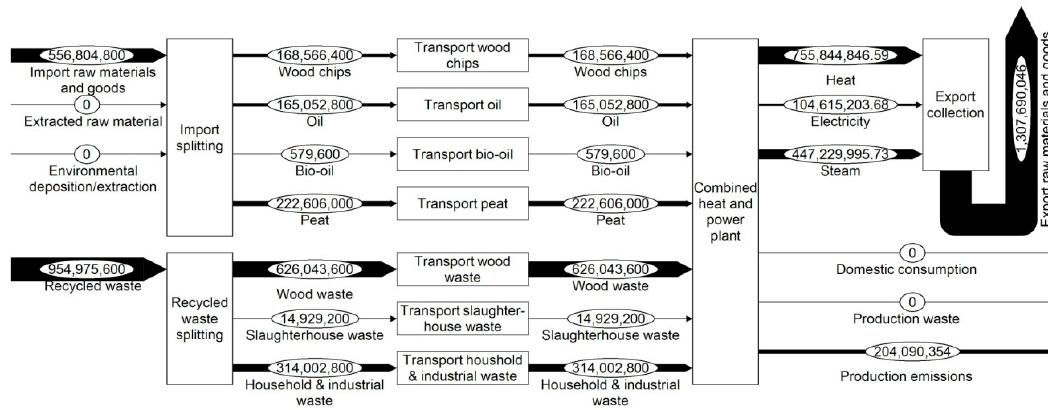
Figure A9. Energy flows of Karlskoga combined heat and power plant, subsystem production.